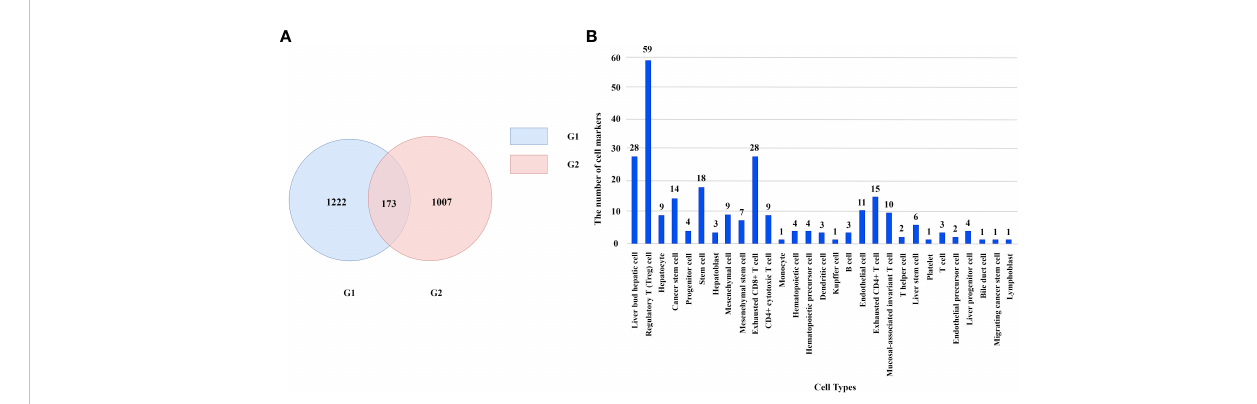
FIGURE 2 (A) The number of genes in different gene sets. (B) The number of marker genes corresponding to immune cells.